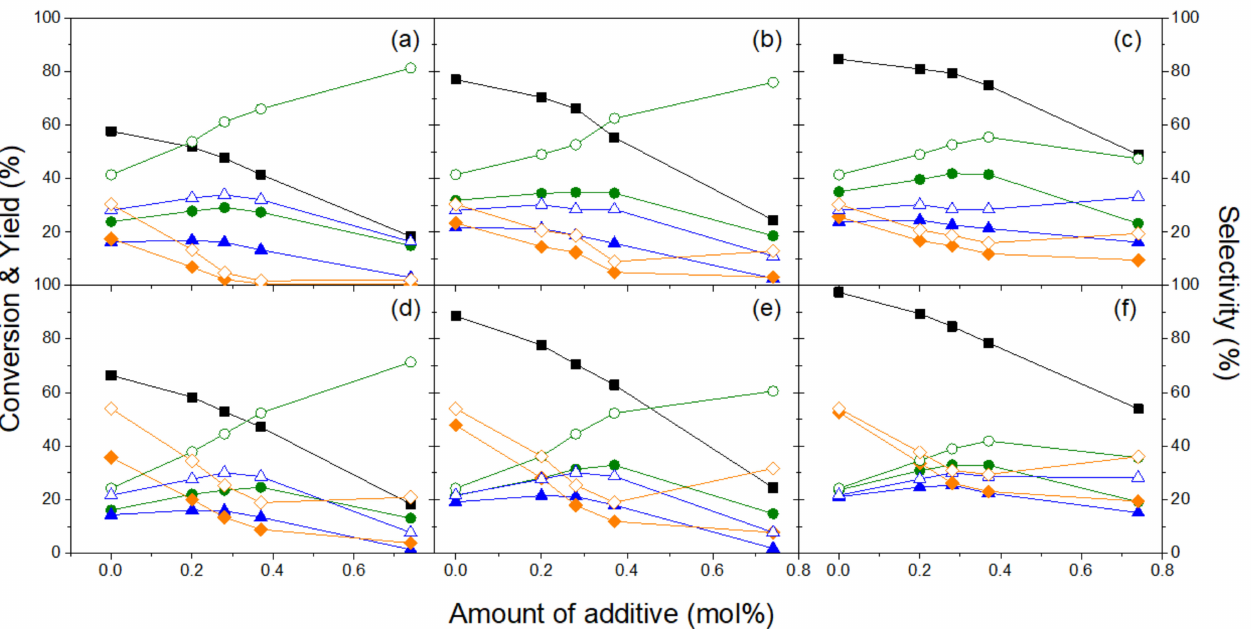
Figure 2. The effect of additive concentration on the etherification of glycerol in the presence of NaOAc (0.5 mol%) at ( a ) 270 ◦ C, ( b ) 280 ◦ C and ( c ) 290 ◦ C and KOAc (0.5 mol%) at ( d ) 270 ◦ C, ( e ) 280 ◦ C, and ( f ) 290 ◦ C with variable amounts of NaHSO 4 and KHSO 4 as an additive (- (cid:4) -: conversion of glycerol, - • -: yield of DG, - (cid:78) -: yield of TG, - (cid:7) -: yield of others - selectivity of DG, - ∆ -: selectivity of TG, - ♦ -: selectivity of others, the reaction time: 2